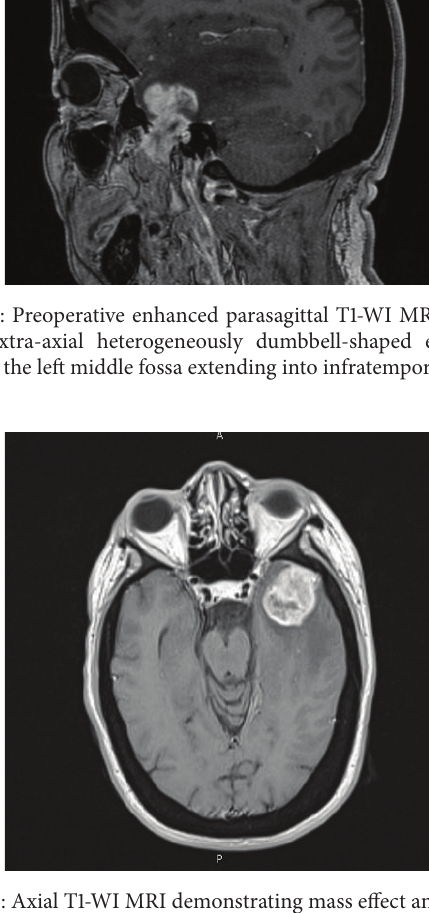
Figure 2: Axial T1-WI MRI demonstrating mass effect and infiltra- tion to the temporal lobe with vasogenic